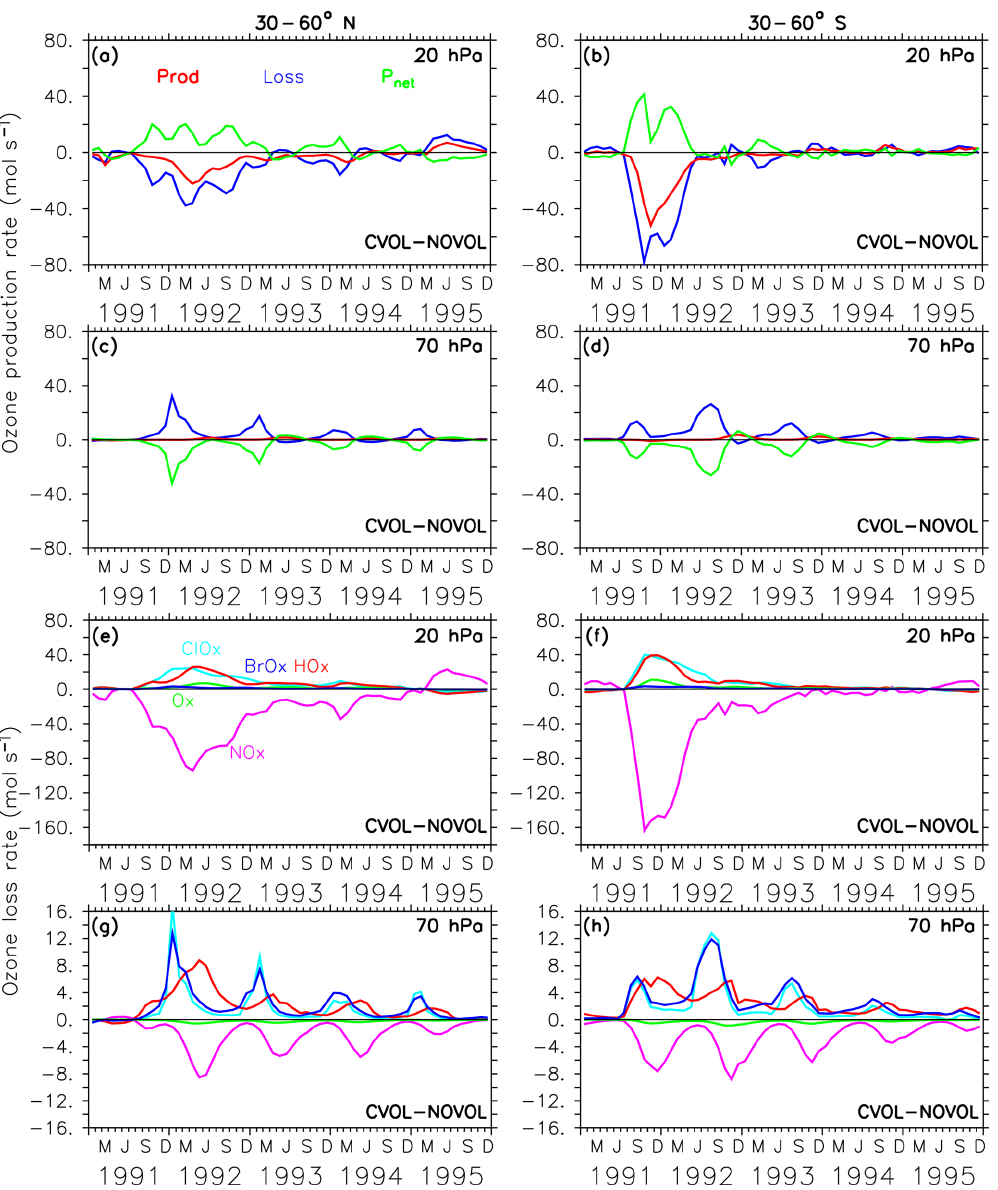
Figure 11. Chemical effect (CVOL − NOVOL) of ozone production (Prod) and loss (Loss) rates (a–d) in midlatitudes and corresponding net ozone production ( P net = Prod − Loss). (a) 20hPa and (c) 70hPa show zonally averaged and latitudinally (30 and 60 ◦ N) summed rates in molecules per second. (b, d) Similar to (a, c) but for 30–60 ◦ S. The levels shown are located at the maximum of the volcanic ozone perturbation. Chemical effect (CVOL − NOVOL) of the zonally averaged and latitudinally summed ozone loss rates (moleculess − 1 ) for each catalytic ozone loss cycle (e–h) for the Northern Hemisphere at 20hPa (e) and 70hPa (g) . (f, h) are similar to (e, g) but for 30–60 ◦ S.